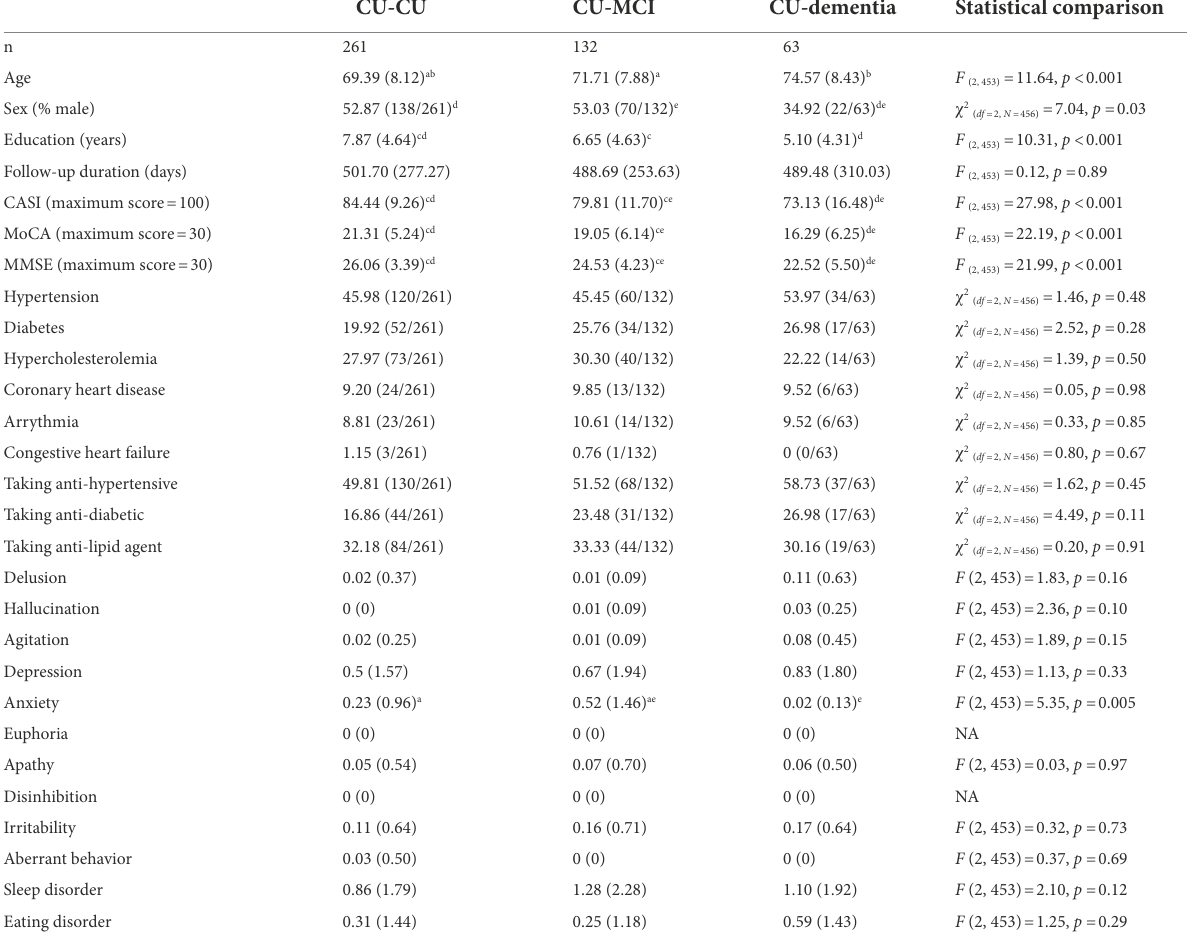
TABLE 1 Demographic and clinical characteristics of CU